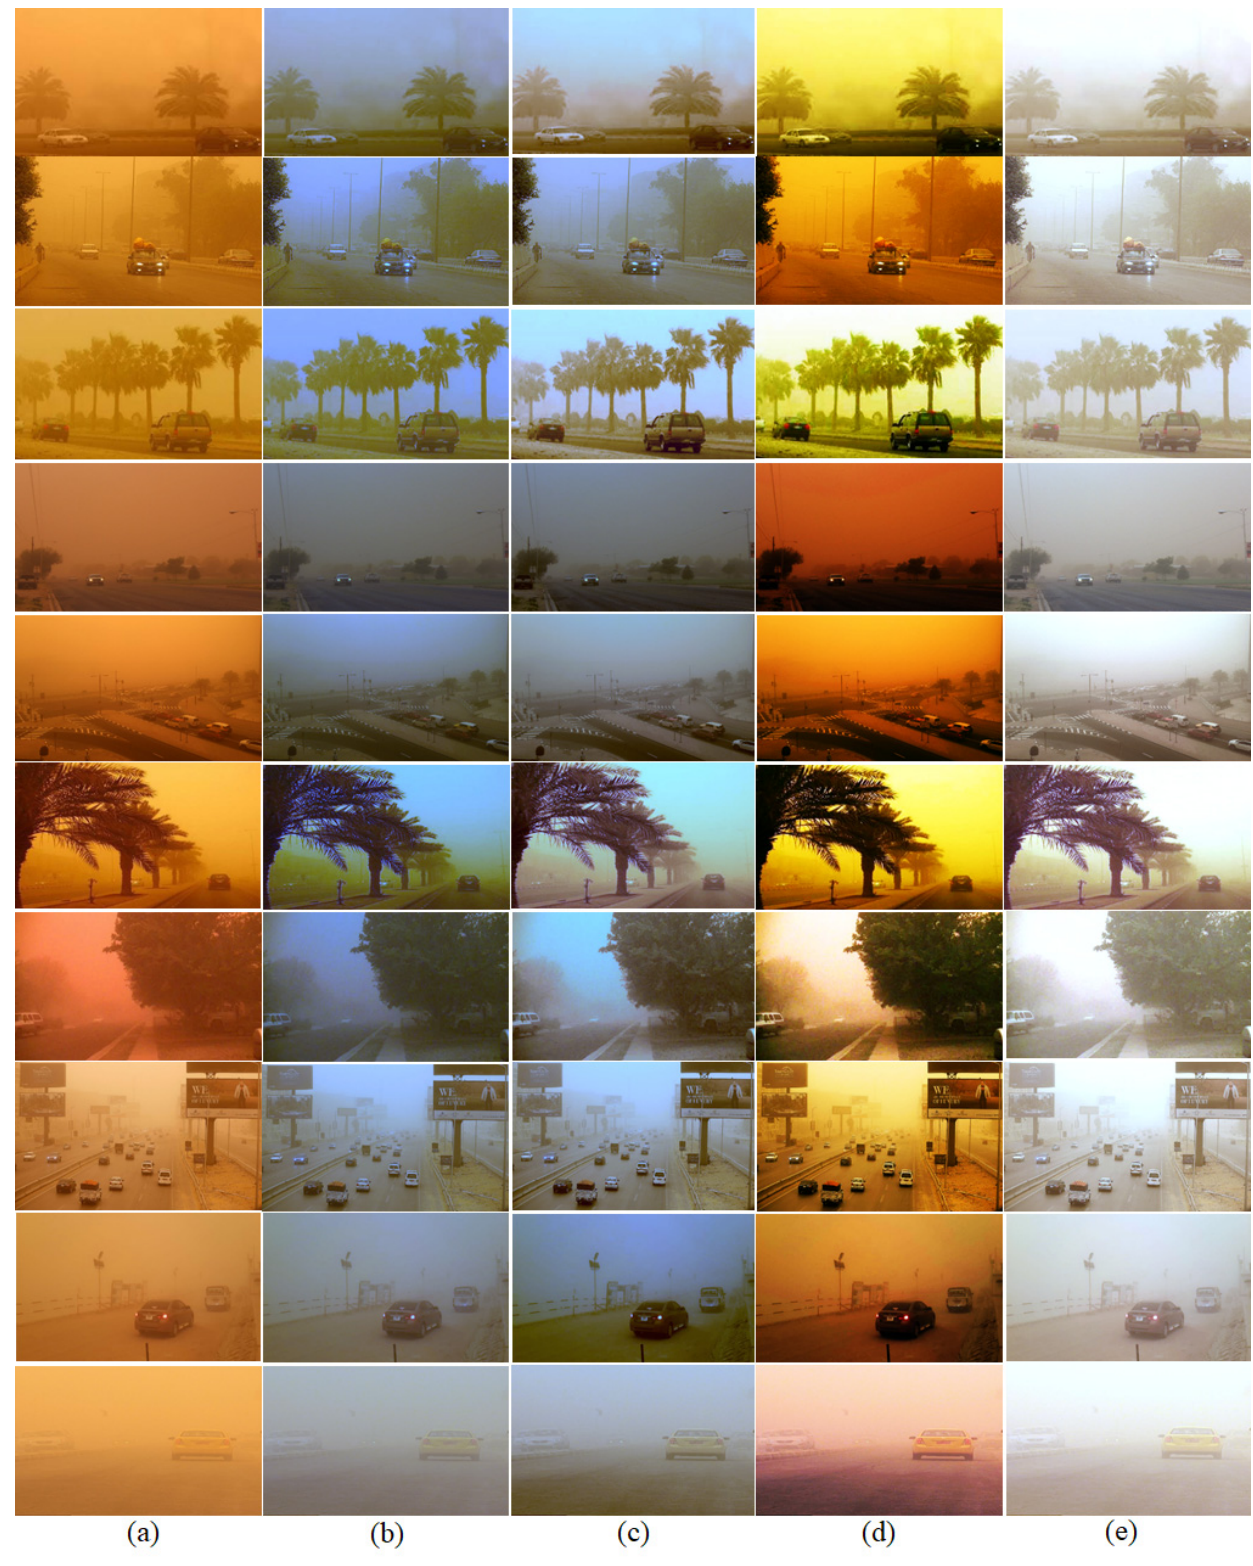
Figure 5. The comparison with state-of-the-art color correction methods and the proposed method on severely degraded duststorm images: ( a ) Input image; ( b ) Shi et al. [8]; ( c ) Shi et al. [12]; ( d ) Al Ameen [4]; ( e ) Proposed method.